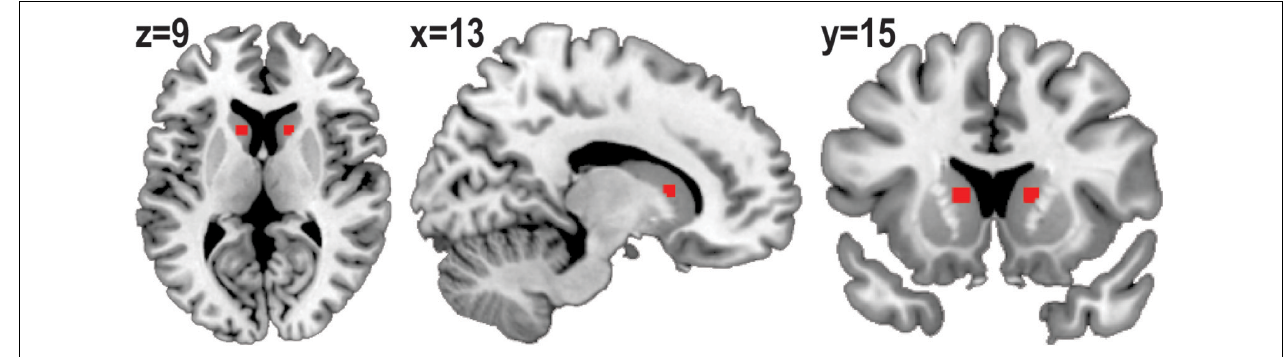
FIGURE 2 | Binarized caudate seed. Three-millimeter spheres were placed centered on (x, y, z) = (13, 15, 9) and (x, y, z) = (–13, 15, 9). Right and left seeds were merged and regions outside of the anatomical caudate area were cut out.